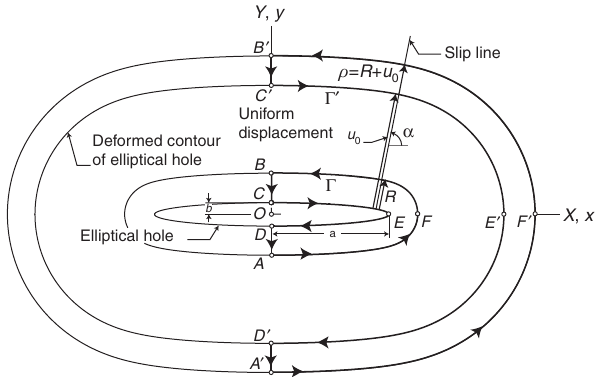
Figure 1: Path of integration in both the initial coordinates ( X , Y ) and in the deformed state ( x , y